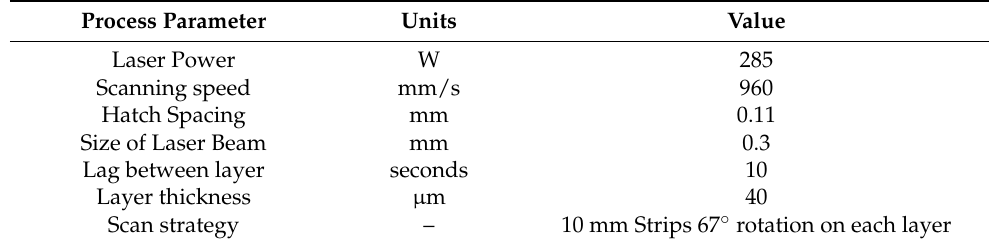
Table 2. IN718 process parameter details for EOS